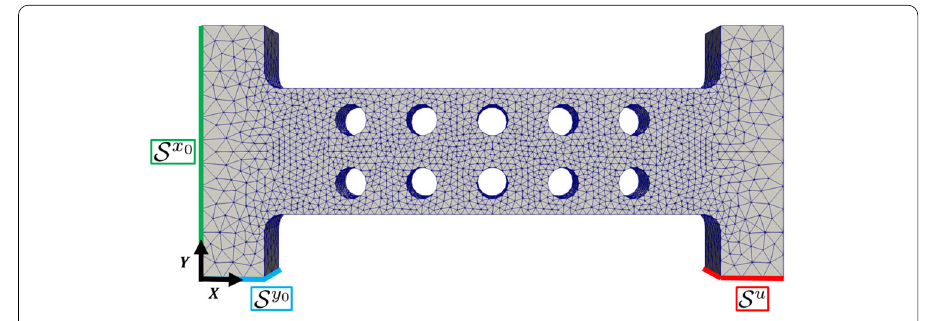
Fig. 4 Finite-element mesh of the structure. Contains 33047 quadratic tetrahedral elements and 54649 nodes. Details about the boundary conditions can be found in Eqs.